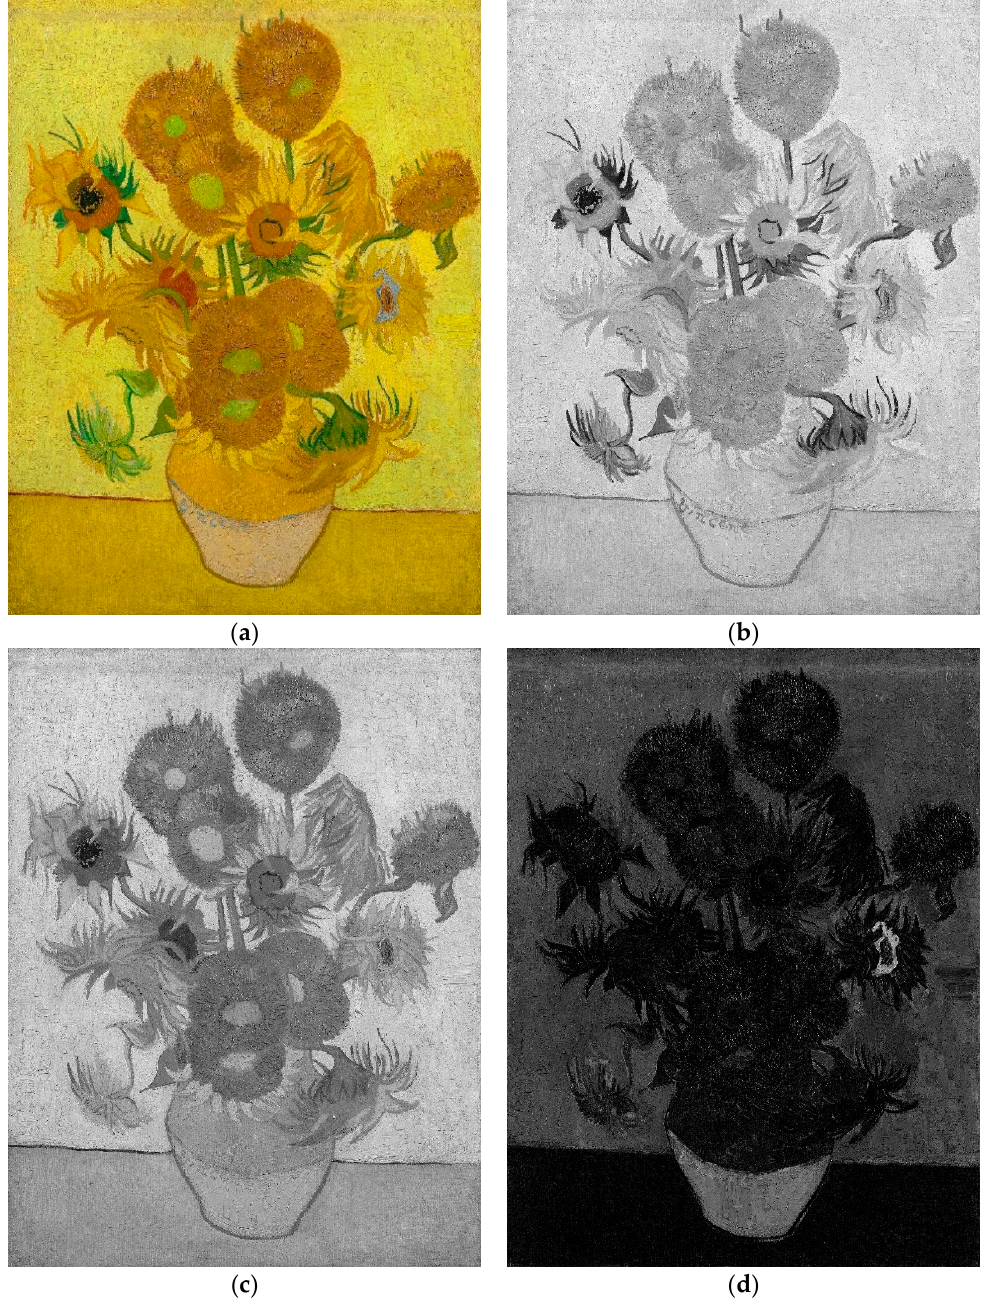
Figure 8. ( a ) Sunflowers; ( b ) Sunflowers R Band; ( c ) Sunflowers G Band; ( d ) Sunflowers B Band.